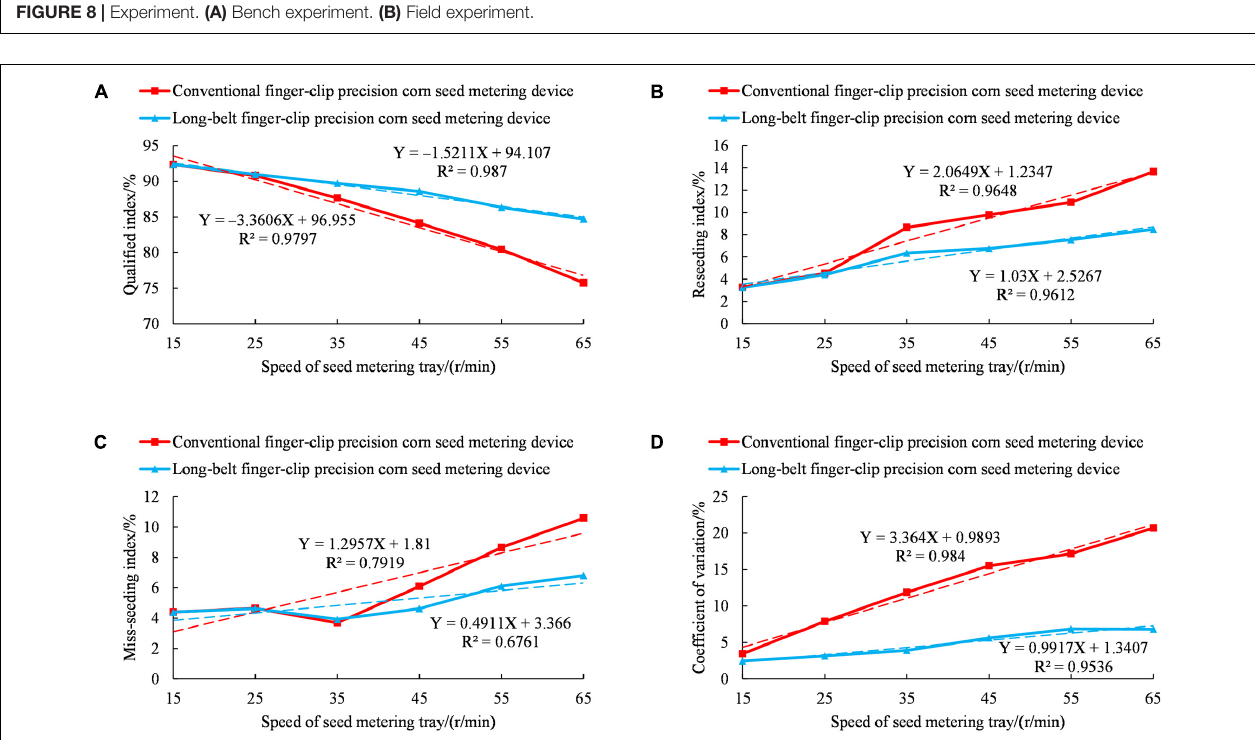
FIGURE 9 | Comparative analysis of the seeding performances for the long-belt finger-clip and conventional finger-clip precision corn seed metering devices. (A) Influence of the rotating speed of the seed metering tray on the qualified index. (B) Influence of the rotating speed of the seed metering tray on the reseeding index. (C) Influence of the rotating speed of the seed metering tray on the miss-seeding index. (D) Influence of the rotating speed of the seed metering tray on the coefficient of